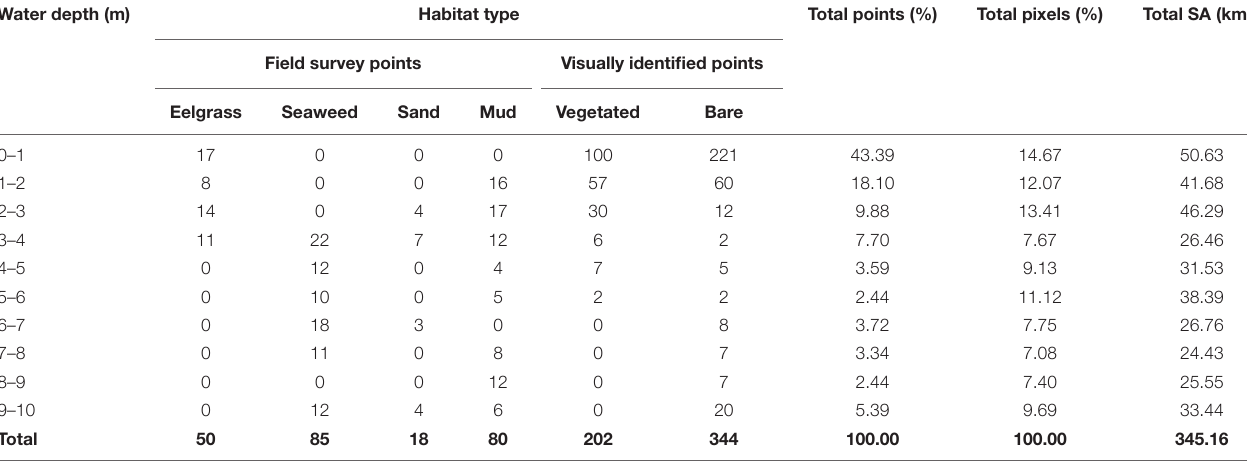
TABLE 1 | Number of field survey and visually identified points by habitat type and water depth (m). Water depth (m) Habitat